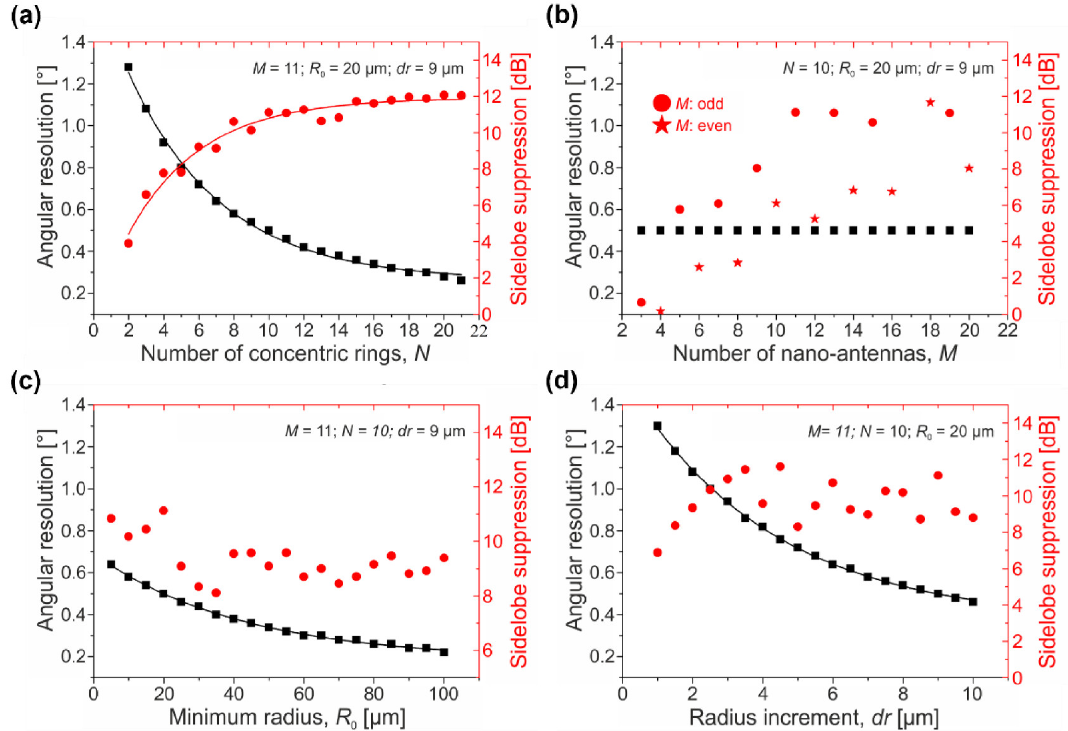
Figure 2. Angular beamwidth and sidelobe suppression of a circular array as a function of ( a ) number of concentric rings, N ; ( b ) number of nano-antennas per ring, M ; ( c ) minimum radius of rings, R 0 ; and ( d ) delta radius between two adjacent rings, dr .